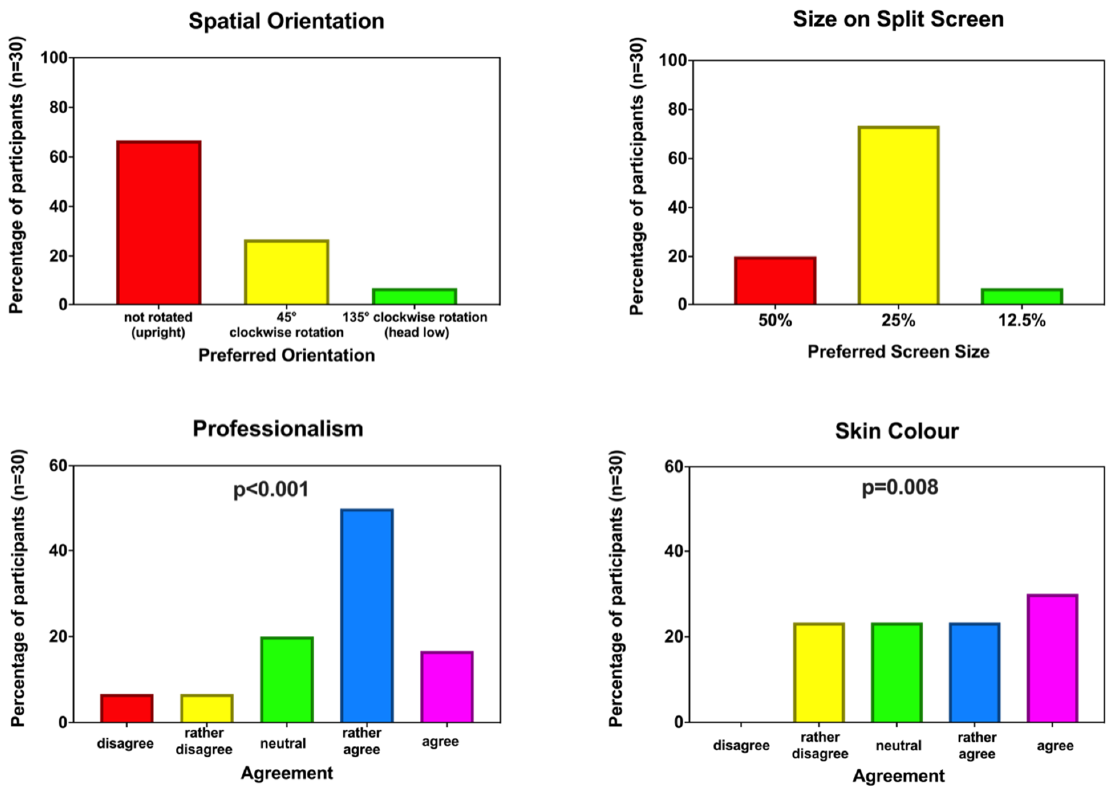
Figure 4. Responses to the general questions in the third, quantitative study part. The p -value indicates statistical difference from neutral (with Wilcoxon signed-rank test).